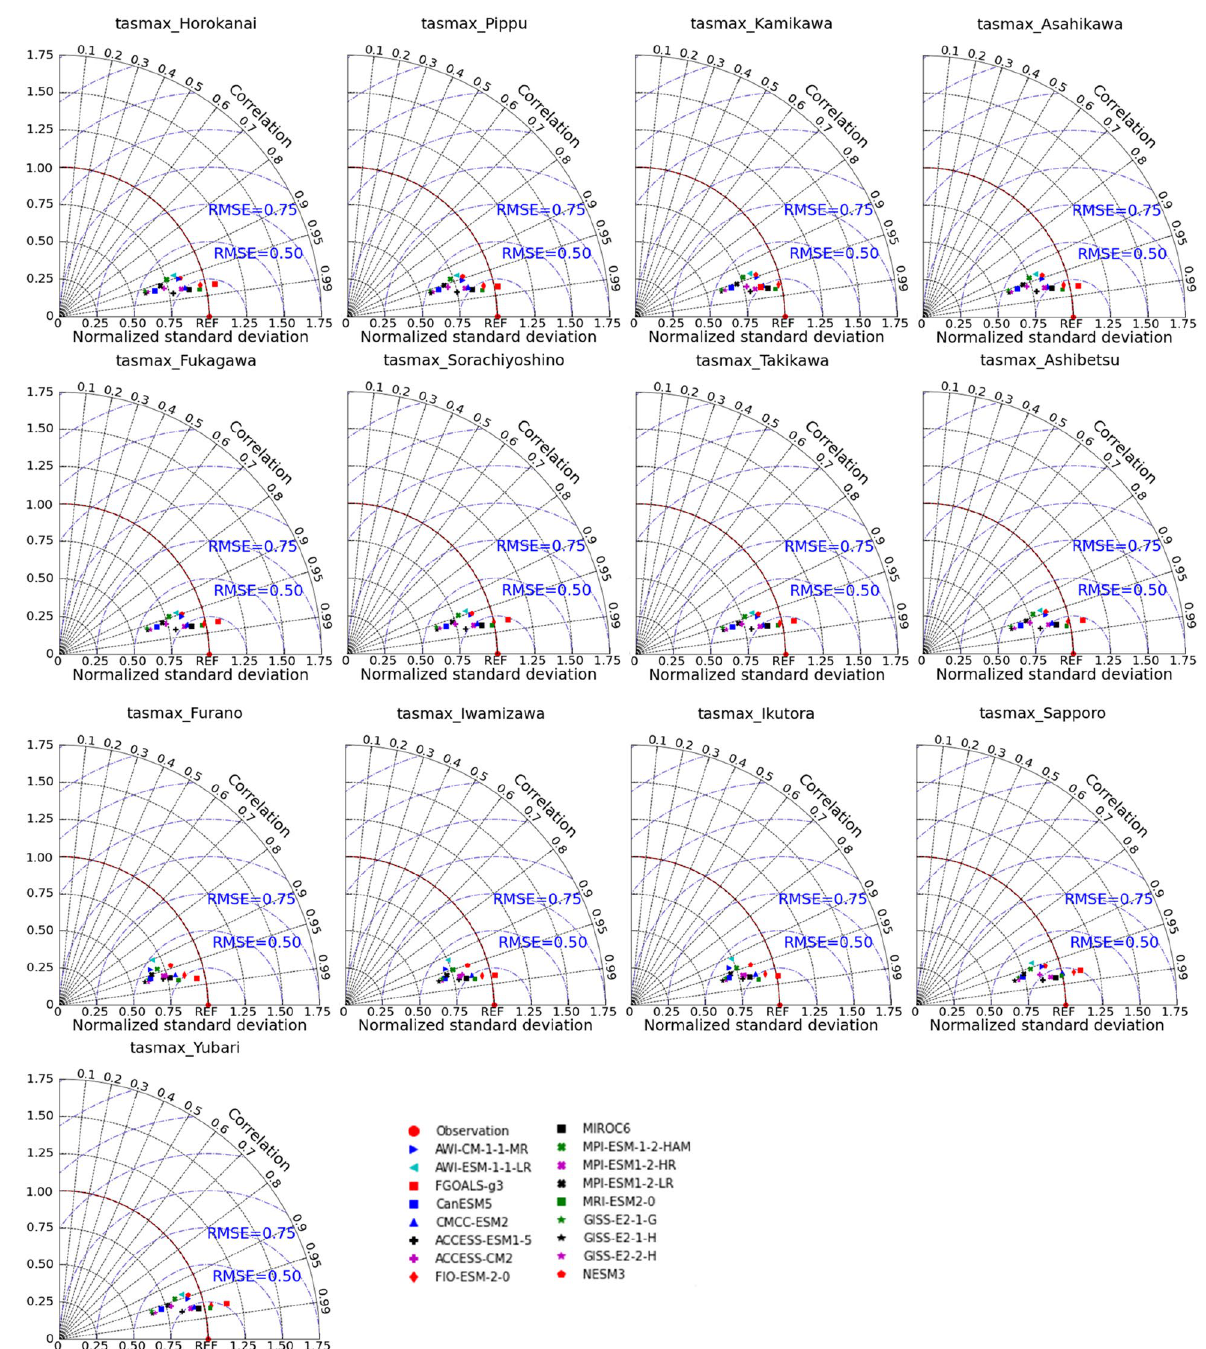
Figure 2. Taylor diagrams of maximum air temperature (tasmax) for each GCM at each